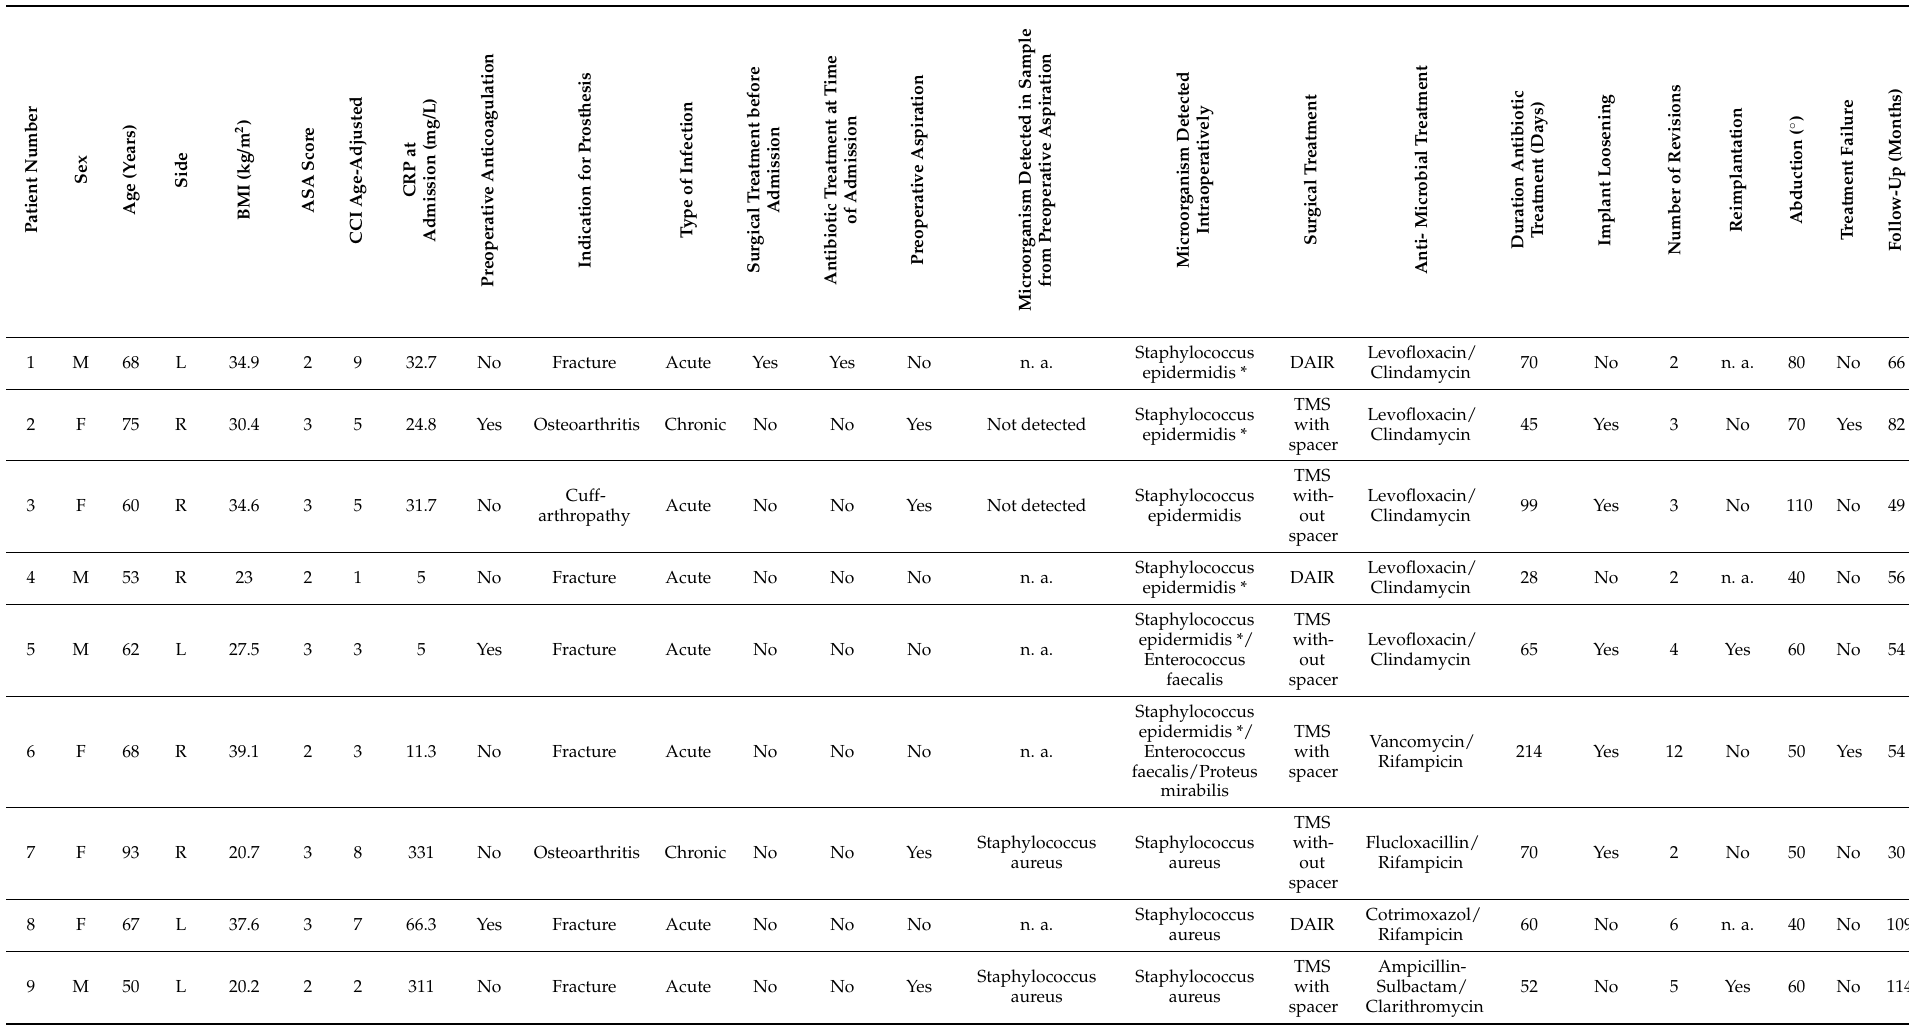
Table 1. Data regarding demographic characteristics, treatment strategies, and outcomes for patients with periprosthetic infection of the